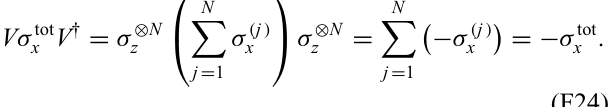
FIG. 5. The relative entropy to the NATS for each qubit pair, as a function of time. The spatiotemporal fluctuations show that different qubit pairs thermalize to different extents. The chain consists of N = 21